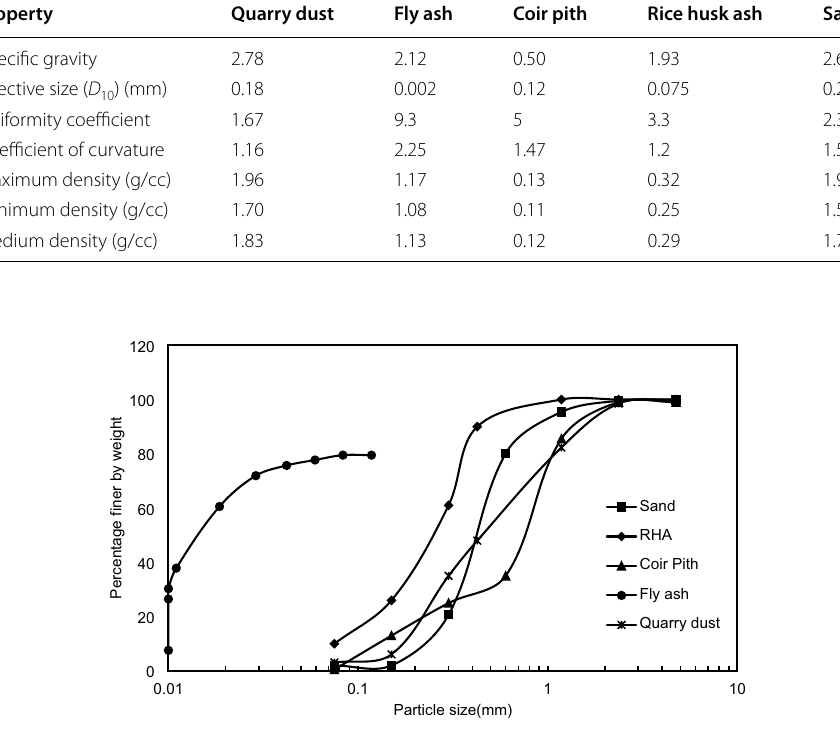
Fig. 1 Particle size distribution of drain